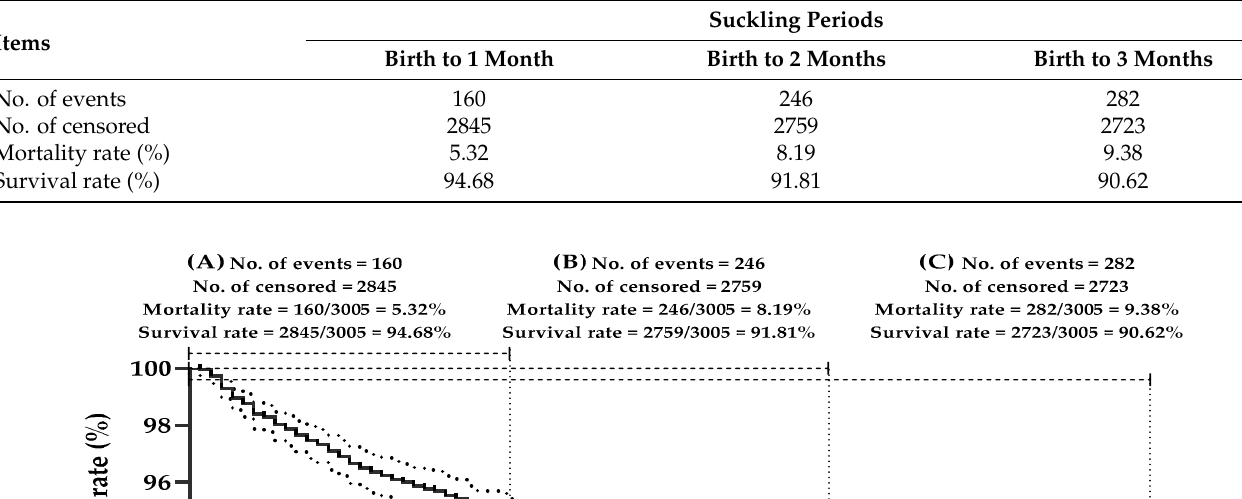
Table 3. Cumulative survival and mortality rates of Zaraibi goat kids during the different suckling periods from birth to 1, 2, and 3 months.